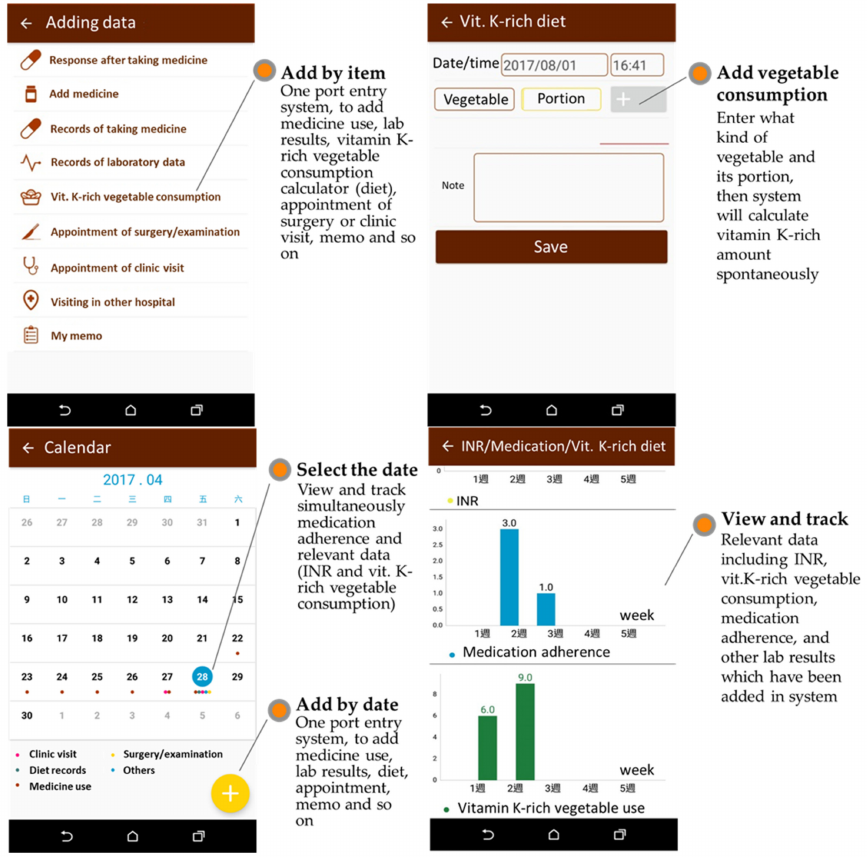
Figure 3. Example of the SmartMed App